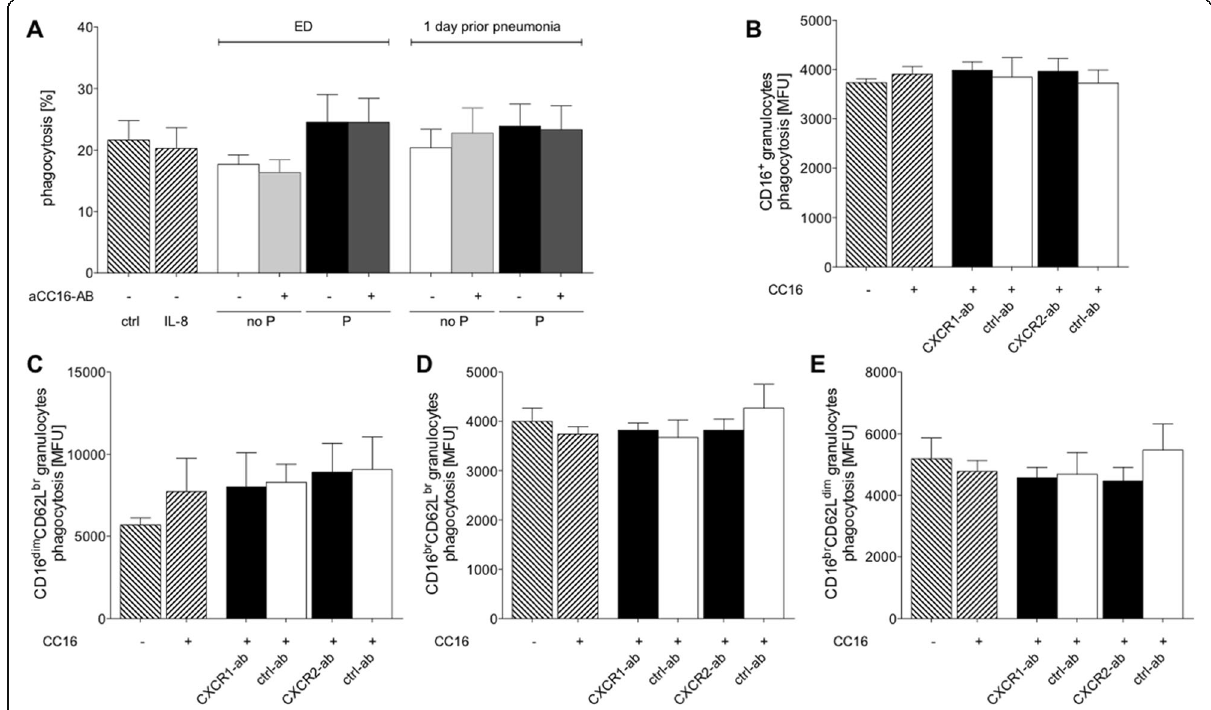
Fig. 4 CC16 does not markedly influence phagocytosis in isolated PMNL. a Phagocytosis of PMNL after their incubation with IL-8 or sera samples from severely injured trauma patients. Patients were grouped to no P group without pneumonia or P group with pneumonia. Samples were obtained at admission to emergency department (ED) and one (Sadeghi-Bazargani et al. 2018) day prior to pneumonia. Samples from the equal post-injury days in the corresponding no P group were used. b Phagocytosis in CD16 + granulocytes after incubation with CC16 and neutralization of CXCR1 (CXCR1-ab), CXCR2 (CXCR2-ab) as well the corresponding isotype control antibodies (ctrl-ab), respectively. c Phagocytosis of immature CD16 dim CD62L bright , ( d ) mature CD16 bright CD62L bright and ( e ) immunesuppressive CD16 bright CD62L dim granulocytes. Data